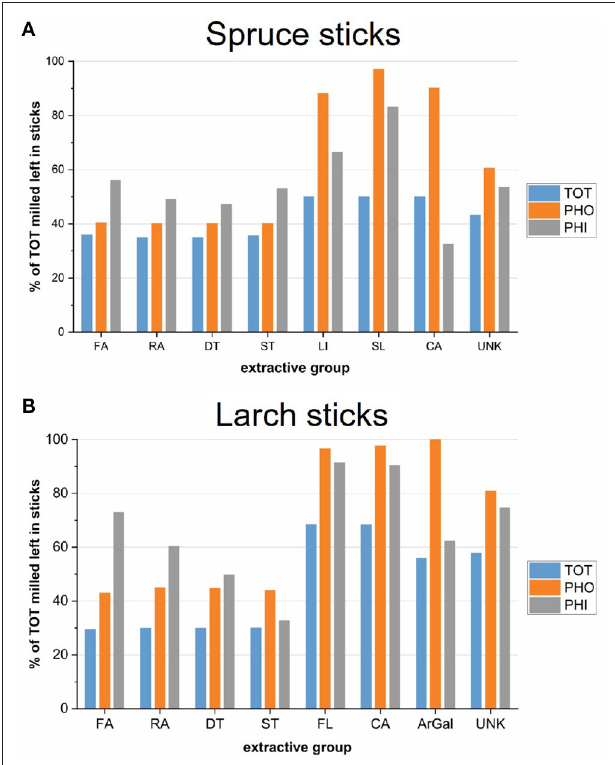
FIGURE 6 | Estimates of the sticks’ monomeric extractive composition after extraction: The chromatographic yields of total extracted, milled samples were weighed by corresponding extraction efficiency and extractive groups summed over the solvent fractions. The water fractions were disregarded. The average of both trees is shown, respectively. (A) Spruce sticks. (B) Larch sticks. FA, fatty acid; RA, resin acid; DT, diterpenoids; ST, sterols; FL, flavonoids; SL, sesquilignans; LI, lignans; CA, carbohydrates and other structural components; ArGal, arabinogalactan; UNK,